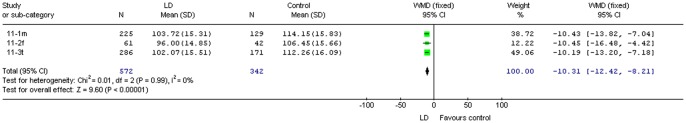
Gender differences.